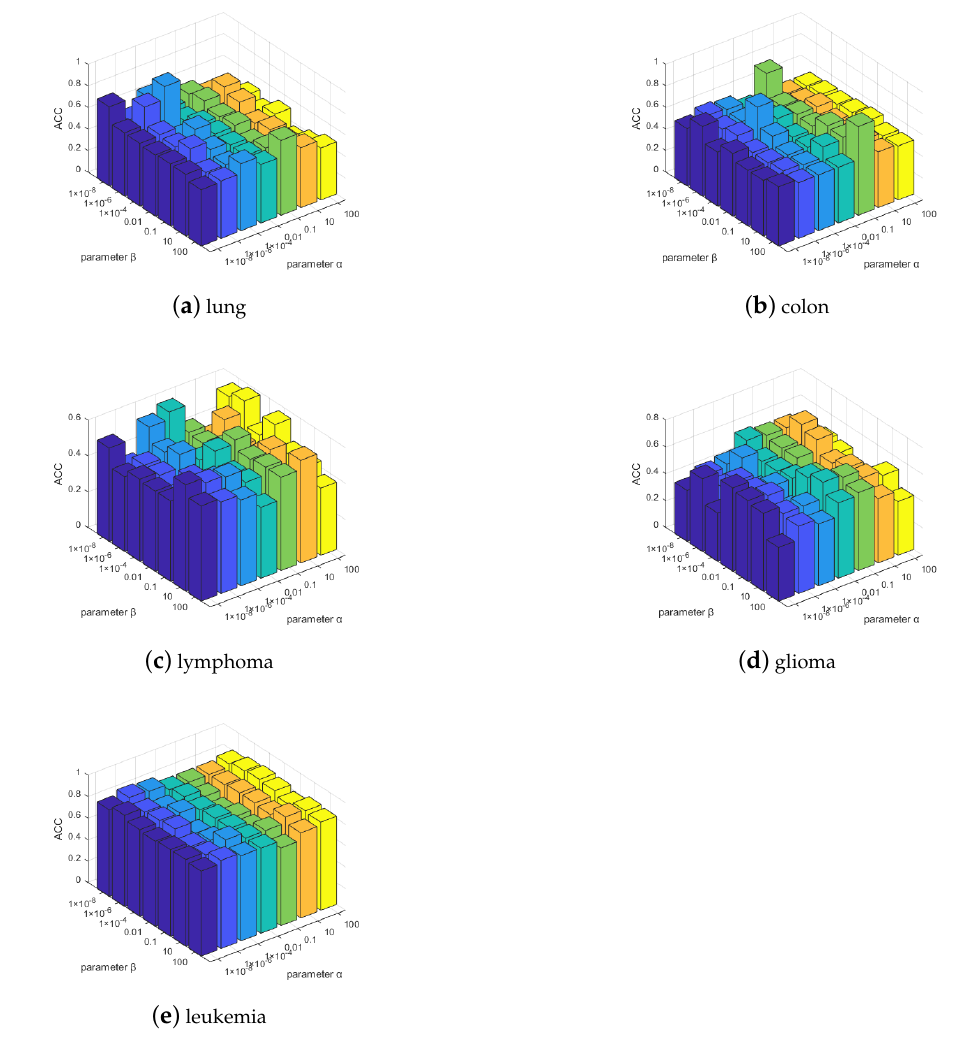
Figure 6. ACC of different parameter combinations on all gene